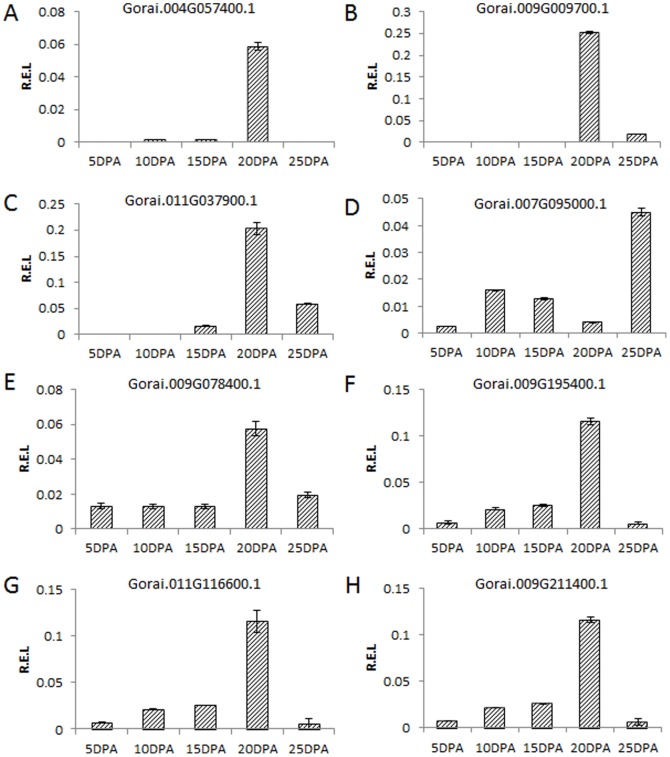
Quantitative RT–PCR validation of tag-mapped genes in TM-1.These genes have been reported before, including 3 CesA genes (A,B,C) (homologous with AtCESA4, AtCESA7, AtCESA8, respectively), xyloglucan endotransglucosylase (D), beta -galactosidase (E), glycosyl hydrolase 9B7 (F), xylan alpha-glucuronosyltransferase 1, GUX1 (G), xylan alpha-glucuronosyltransferase 2, GUX2 (H).